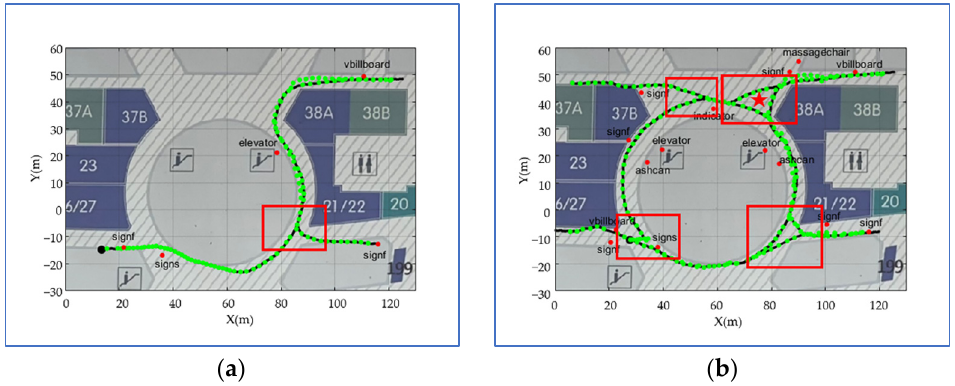
Figure 10. The comparison between the initial and fused venue maps in the shopping mall scene. ( a ) The initial venue map, and ( b ) the fused venue map.